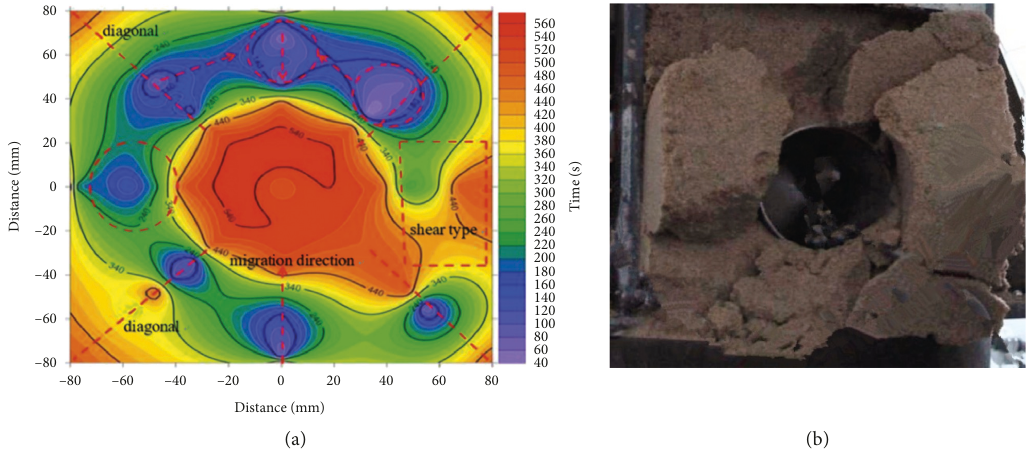
Figure 10: The strain-time cloud map and macrofracture figure: (a) the start time of strain and measurement points cloud map (b) the macrofracture figure.